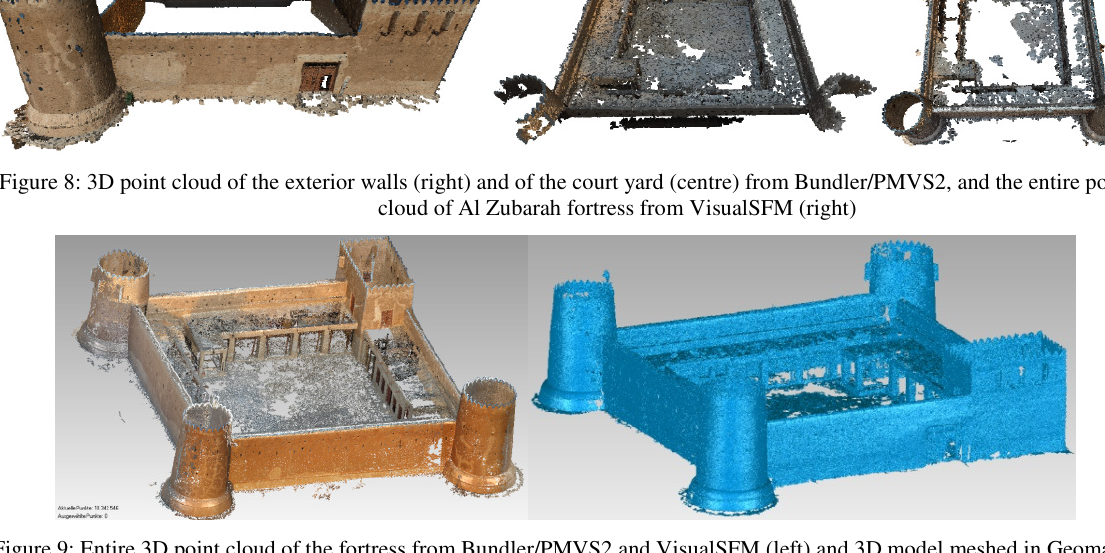
Figure 9: Entire 3D point cloud of the fortress from Bundler/PMVS2 and VisualSFM (left) and 3D model meshed in Geomagic (right)